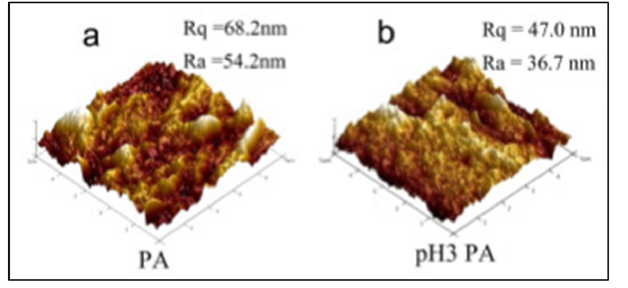
Figure 10. 3D AFM data of polyvinylidene fluoride (PVDF) / polyvinylalcohol (PA) membrane: ( a ) Original surface, ( b ) surface after fouling due to the exposure to natural organic matter (pH3) [46].